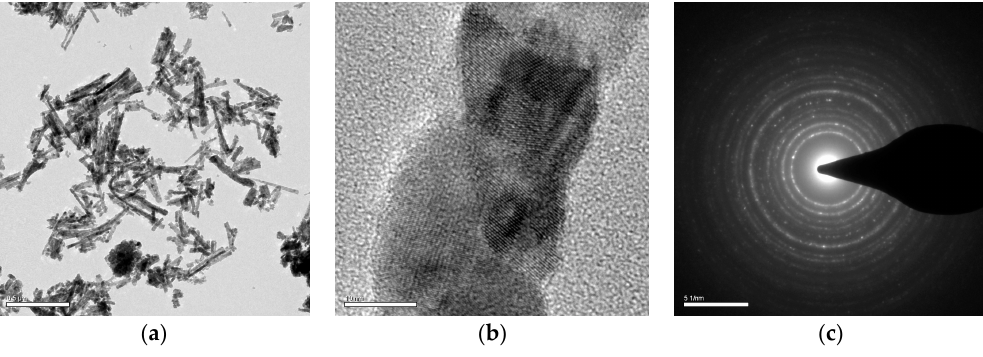
Figure 1. ( a ) The transmission electron microscopy (TEM) images of the scraped TiO 2 nanowire (scale bar: 0.5 μ m); ( b ) the high resolution TEM images of a part from a single TiO 2 nanowire (scale bar: 10 nm); ( c ) selected area diffraction pattern of TiO 2 nanowire (scale bar: 51/nm).